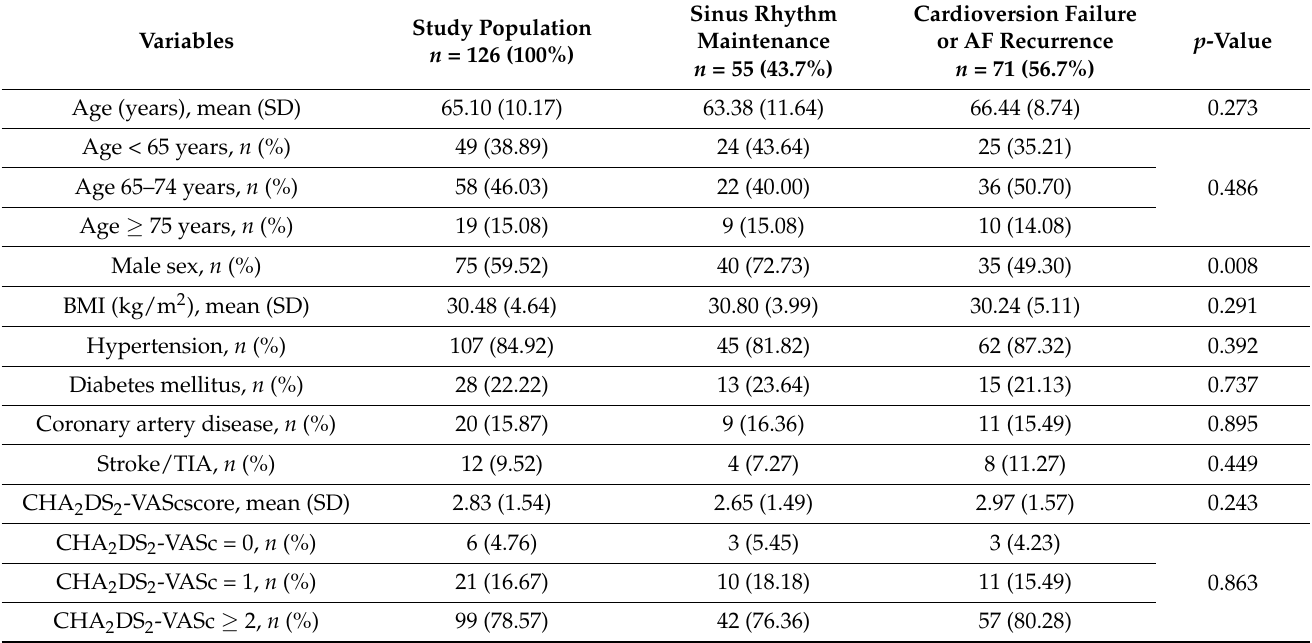
Table 1. Clinical